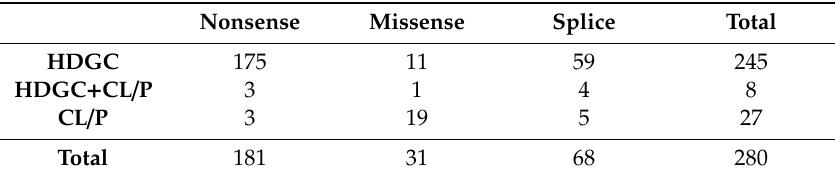
Table 1. Numbers of variants by variant type and phenotype. Nonsense